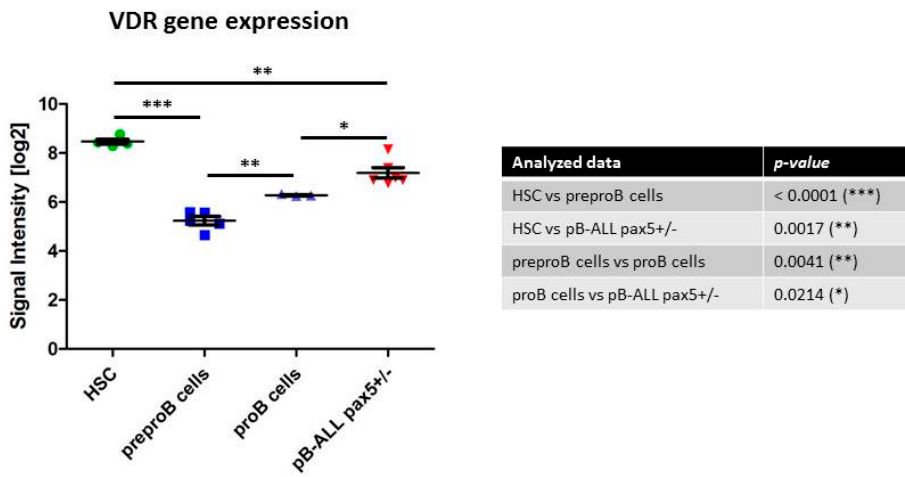
Figure 4. VDR (vitamin D receptor) expression in normal HSC, preproB cells, and proB cells subsets compared to pB-ALL cells from pax5+/ − mice. Using publicly available gene expression microarray data [48], we compared VDR transcript abundance in normal murine HSC and preproB cells examined using Affymetrix Mouse Genome 430 2.0 Array with control pro-cells and pB-ALL cells from pax5+/ − examined using Affymetrix Mouse Gene 1.0 ST arrays [50]. The highest expression of VDR gene was observed in normal HSC followed by the tumor differentiated cells from leukemic pax5+/ − mice. Error bars represent the standard deviation. The Unpaired t -test has been used and p -values are indicated in the table.